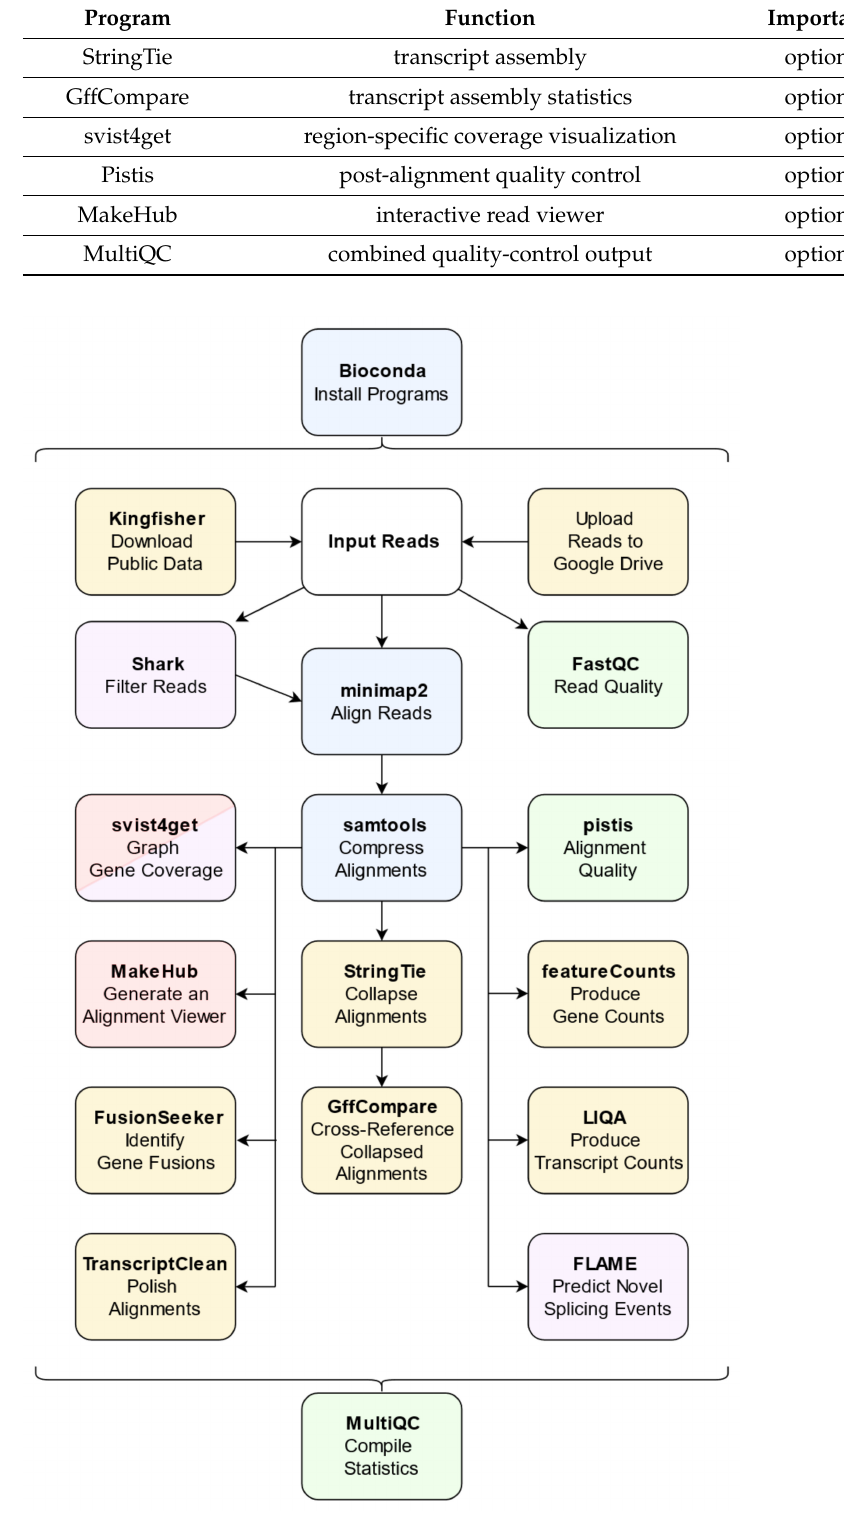
Figure 2. Overview of L-RAPiT components and workflow. Colors reflect the general purpose of each program: core elements of the pipeline are shown in blue; quality control programs in green; visualization programs in red; region-specific programs in purple; and other optional pipeline components in yellow. Arrows indicate the use of output from one program as input for